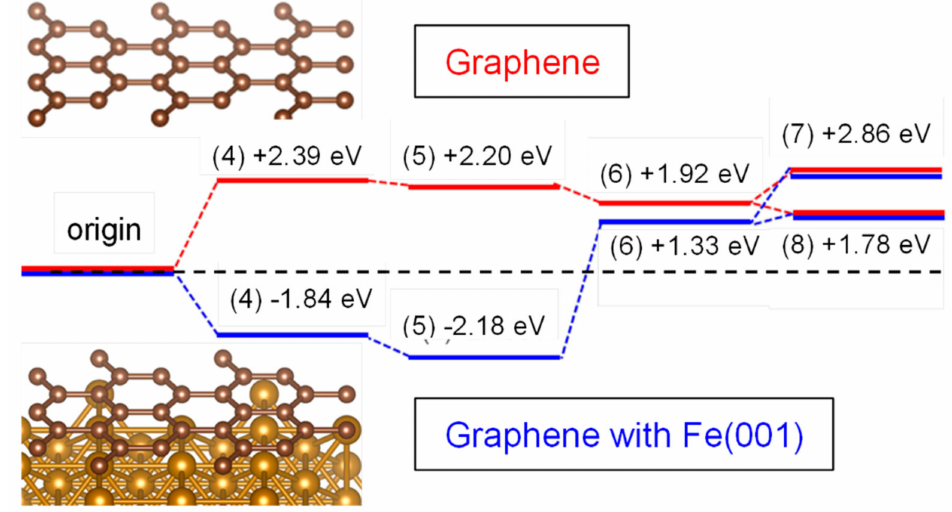
Figure 6. The energy diagrams for the reactions from O 2 adsorption to generate HO 2 − or OH −